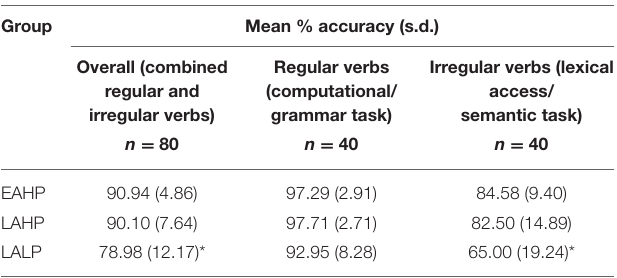
Group Mean % accuracy